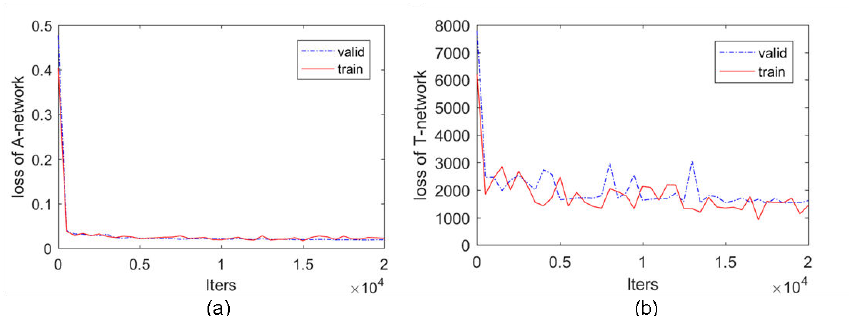
Figure 8. Training and validation loss over the training process. ( a ) loss of A-network; ( b ) loss of